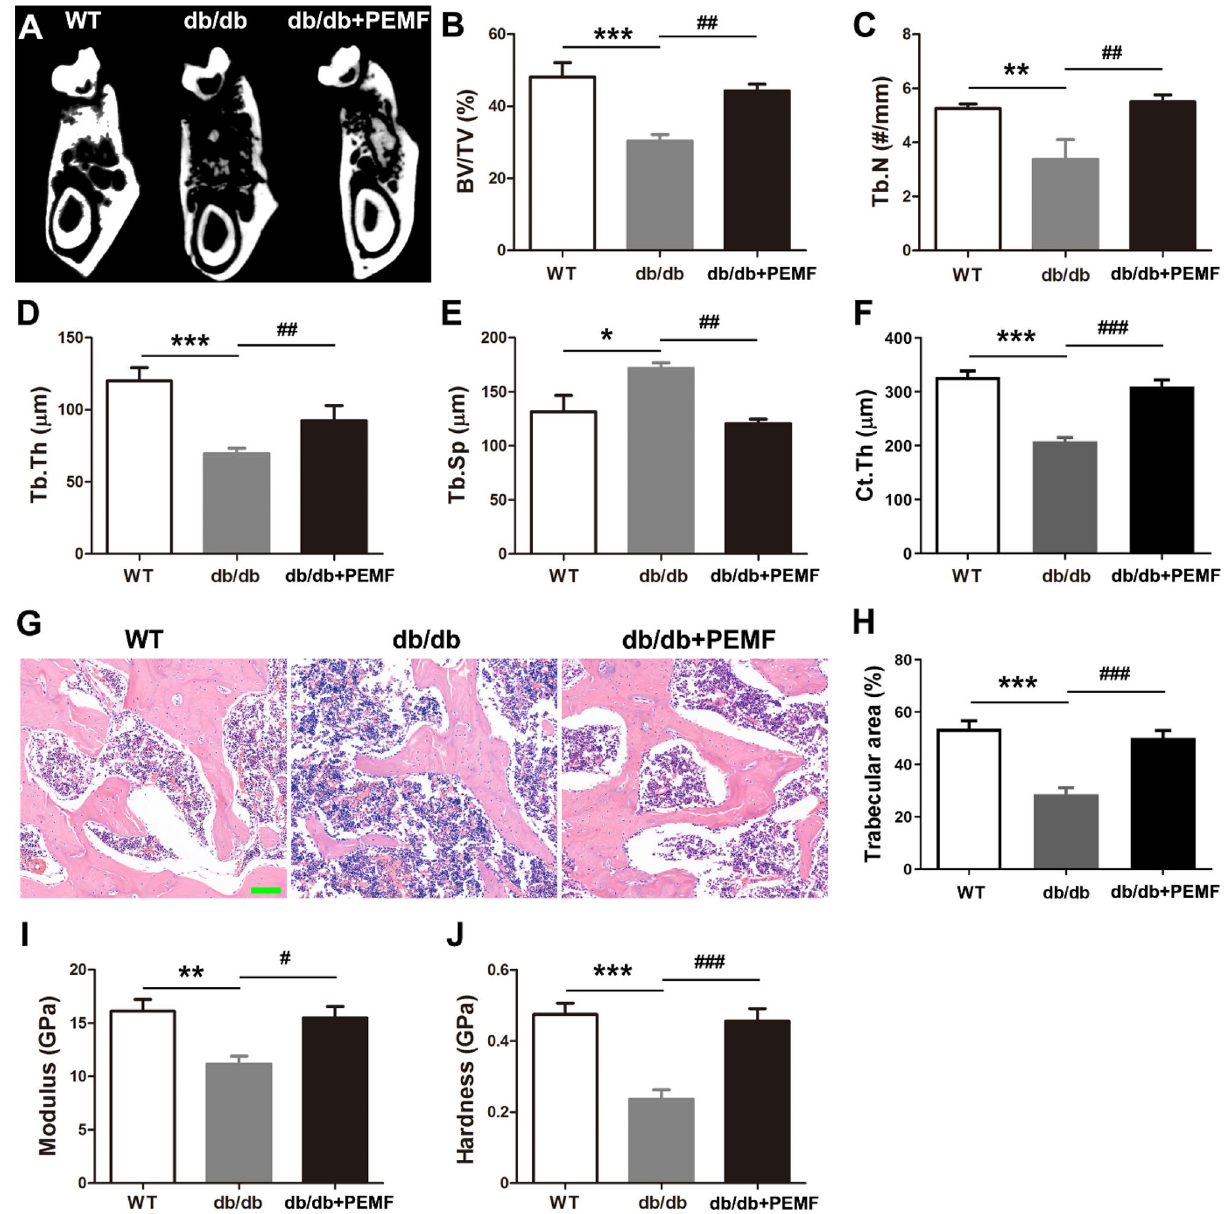
Figure 1. Pulsed electromagnetic fields (PEMF) exposure for 12 weeks improves in vivo mandibular bone microarchitecture and material properties in type 2 diabetic db/db mice. ( A ) Representative micro-CT images showing mandibular bone microarchitecture in the wild-type mice group (WT), the db/db mice group (db/db), and the db/db mice with PEMF stimulation group (db/db + PEMF). (B–F) Statistical comparison of micro-CT data, including (B) trabecular bone volume per tissue volume (BV/TV), (C) trabecular number (Tb.N), (D) trabecular thickness (Tb.Th), (E) trabecular separation (Tb.Sp), and (F) cortical thickness (Ct.Th). (G,H) Analysis of mandibular trabecular bone microstructure based on H&E staining. Scale bar represents 100 µm. (I,J) Analysis of mandibular trabecular bone material properties based on nanoindentation testing, including (I) modulus and (J) hardness. Data are represented as mean ± SEM ( n = 9/group). * P < 0.05, ** P < 0.01, *** P < 0.001 vs. the WT group; # P < 0.05, ## P < 0.01, ### P < 0.001 vs. the db/db group by one way analysis of variance (ANOVA) followed by Bonferroni’s multiple